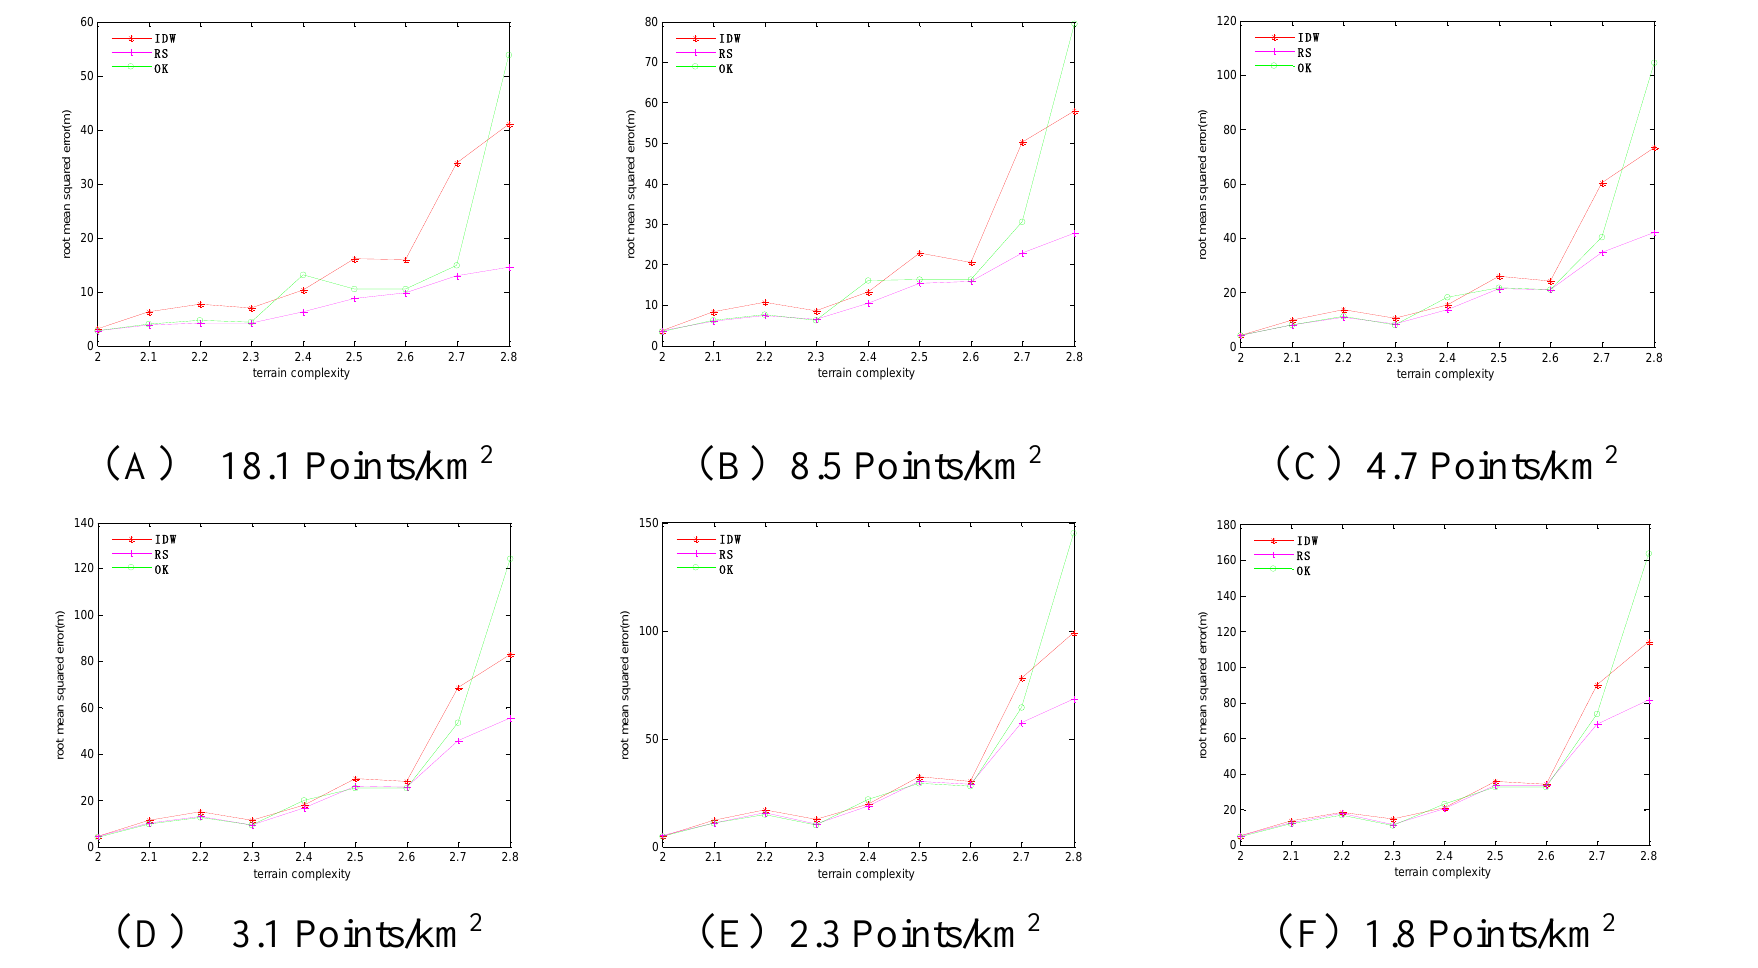
Figure 6. The RMSE s of the 3 methods in regular-grid sampling. Sampling densities of ( A ) 18.1 points/km 2 ; ( B ) 8.5 points/km 2 ; ( C ) 4.7 points/km 2 ; ( D ) 3.1 points/km 2 ; ( E ) 2.3 points/km 2 ; ( F ) 1.8 points/km 2